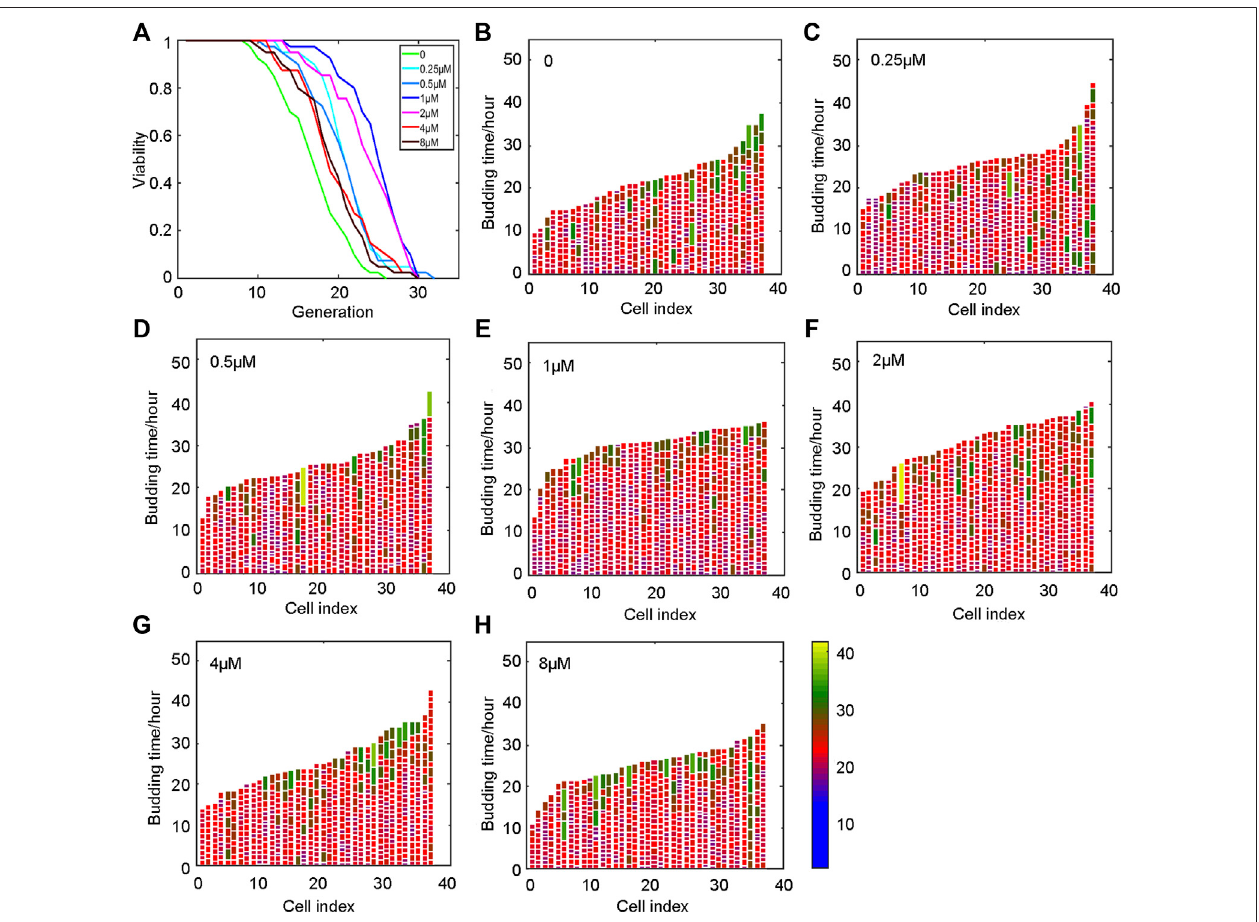
FIGURE2| Oridoninprolongsthelifespanofyeast. (A) Oridoninextendsthereplicationlifeofyeast. (B – H) Germinationdiagramsofwild-typeandoridonin-treated mother cellsshowcellcycledurationandheterogeneity( A – H , n =40foreachgroup) (seeindex colorscale.Durationis1.4 horless.Cellcycleiscoloredincolorpurple). The x-axis shows a single parent cell as a vertical bar, while budding events are shown as white horizontal partitions.